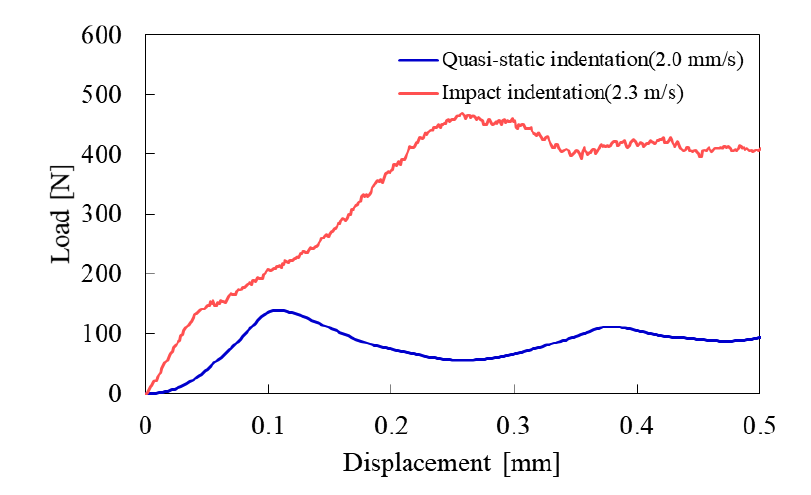
Fig. 4. Relationships between typical load and displacement in impact and quasi-static